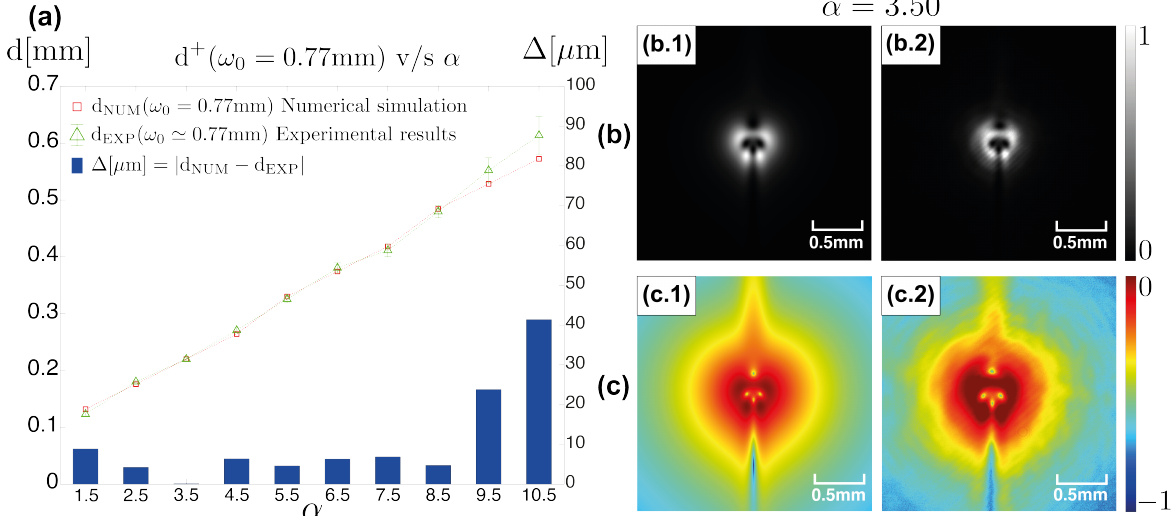
Figure 4. ( a ) Distances of resident vortices with fractional steps of 0.5; numerical simulation (red square), and experimental measurements (green triangle) comparison. ( b ) Normalized